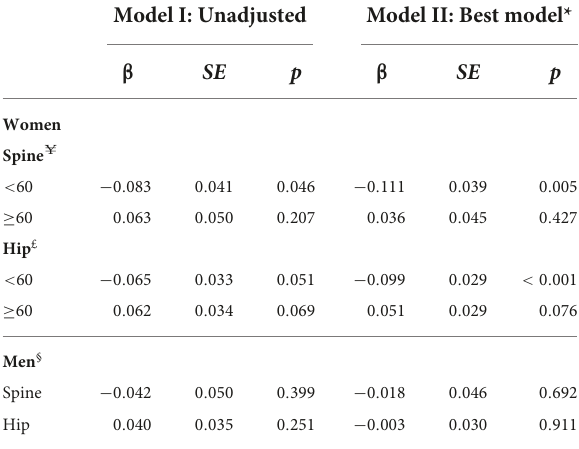
TABLE 2 Unadjusted and best models showing associations between antipsychotic use and BMD for women and men. Model I: Unadjusted